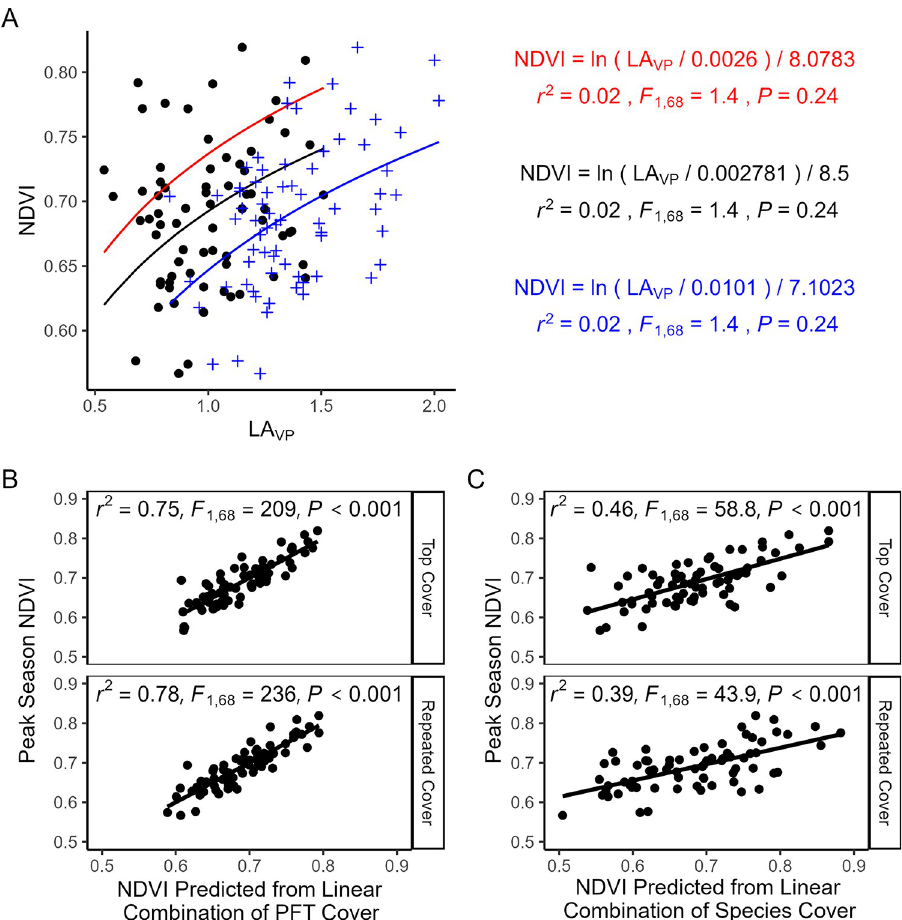
Fig 3. (A) Observed peak-season NDVI in the MAT sample plots regressed against plot-level vertically projected leaf area (LA vp ) using the LAI~NDVI model (Eq 4), solved for NDVI. Black line and text show the best fit parameters estimated using nls with LA VP calculated using vascular species only, red shows the pan-Arctic parameters used in Shaver (2007, 2013), and blue shows best fit parameters with LA VP calculations that include moss. (B) Observed peak- season NDVI regressed against NDVI predicted from a multiple regression model using top cover (first pin hits only) or repeated cover of eight PFTs or (C) individual species as predictors. Goodness-of-fit statistics are inset. Regression coefficients are in Tables 1 and 2. between plot-level LA and NEE , GPP , or R unless moss was included in LA calcu- VP 600 600 VP eco lations (Fig 5B and 5C). With moss included, LA was a significant predictor of NEE , VP 600 GPP , and R , but the fit was poor ( r 2 < 0.25 for all three models). 600 eco Regression models using top cover of the five photosynthetic PFTs to predict peak season NEE , GPP , and R were significant ( P < 0.001 for all three) and fit the data somewhat 600 600 eco better, explaining 39%, 48%, and 22% of the variation, respectively (Table 3). Deciduous shrub and forb cover were negatively correlated with NEE and positively correlated with GPP 600 600 (increasing CO uptake associated with increasing shrub and forb cover), while moss also 2 exhibited a positive effect on GPP . Forb cover was also positively correlated with R , being 600 eco the only PFT to exhibit a significant relationship with this variable. Plot-level light curve parameters were partially predicted by PFT cover (Table 4). The initial slope of the light curve, E , was significantly predicted by cover of the five photosynthetic PFTs 0 ( F = 10.6, r 2 = 0.46, P < 0.001), with deciduous shrubs and forbs driving steeper initial 5 , 62